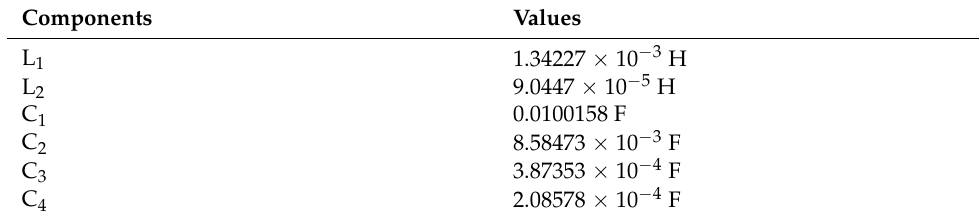
Table 3. SCZEB-converter design